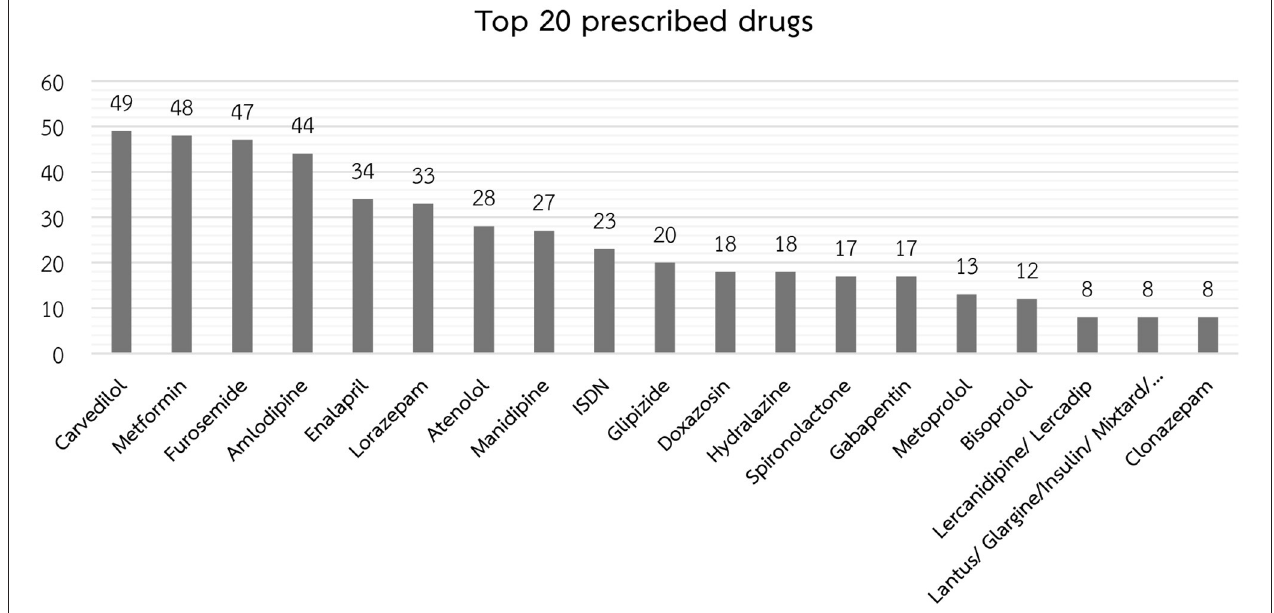
FIGURE 2 | The top 20 most frequently prescribed drugs in the polypharmacy group (results shown as the number of patients out of the 185 patients in the polypharmacy